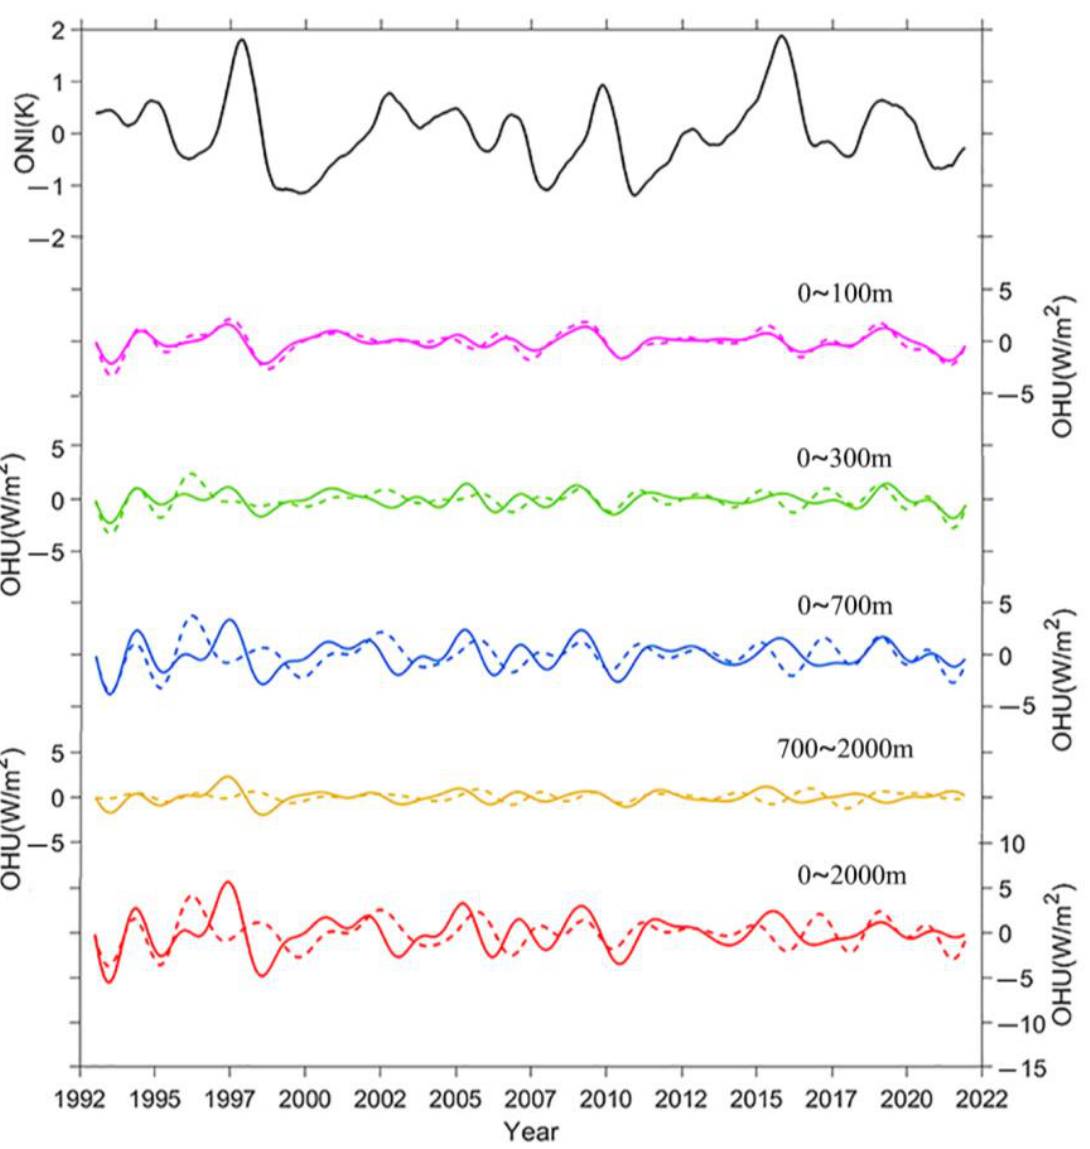
Figure 7. Time series of ONI and global OHU from the OPEN (solid line) and IAP (dashed line) datasets within 0–100 m, 0–300 m, 0–700 m, 700–2000 m, and 0–2000 m. In the time series of ONI, a 12 month running mean was used to eliminate high frequency signals. High and low frequency filters are applied to OHU before further analyses.